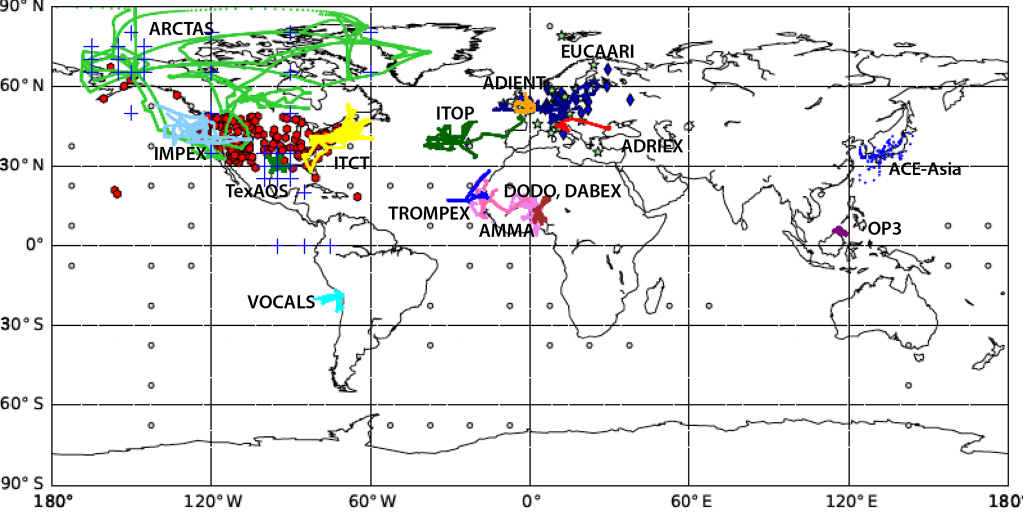
Figure 2. Networks of surface stations and research aircraft flight tracks used for model evaluation. Blue diamonds: EMEP stations with sulfate concentrations; red hexagons: IMPROVE stations with concentrations of sulfate, BC, and OC. Continuous color lines: aircraft flights for the evaluation of sulfate and OC vertical profiles (as described in Fig. 1 in Heald et al., 2011); blue crosses: regions for the evaluation of BC vertical profiles (Koch et al., 2009). Green stars: European sites with size distributions (Asmi et al., 2011a); grey circles: oceanic regions with size distributions (Heintzenberg et al.,